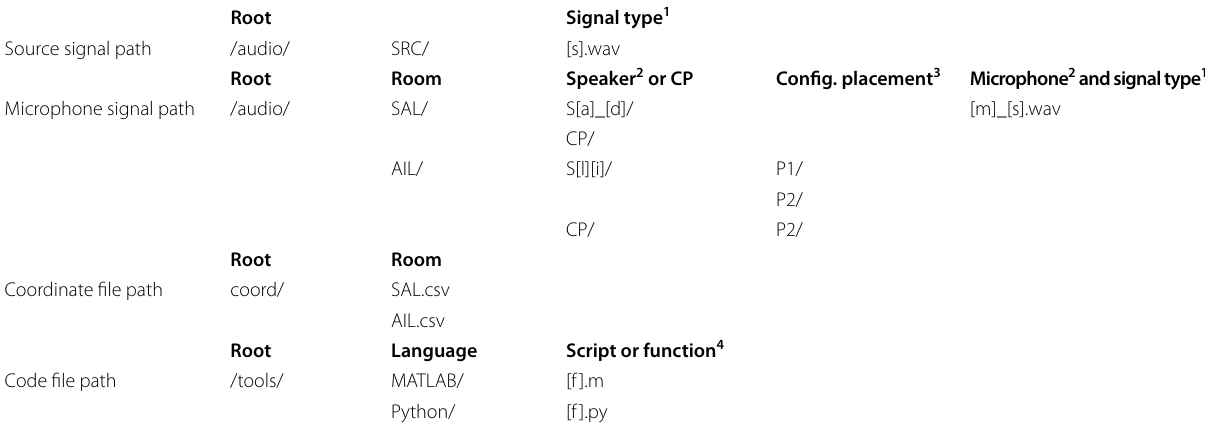
Table 4 File path structure of the database